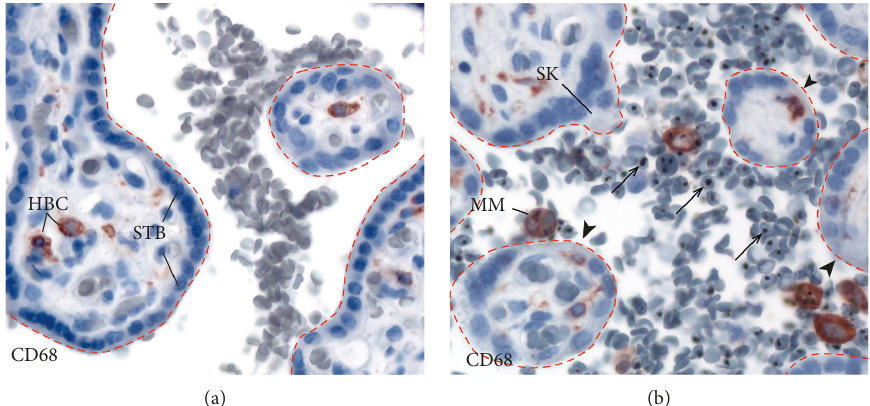
Figure 1: (a) Normal placenta. The dashed lines outline placental villi. Maternal RBCs are seen in the intervillous space. The placental villous (outlined with red dotted lines) is lined by the syncytiotrophoblast (STB). Fetal Hofbauer cells (HBCs) are located in the villous core. (b) Malaria-infected placenta. iRBCs (arrows) accumulate in the intervillous space, and the villous surface is denuded (arrowhead). Infected red blood cells (arrows) and maternal intervillous monocytes (MIM) are found within the intervillous space. A syncytial knot (SK) is a histologic sign of placental remodeling from pathologic processes. HBC: Hofbauer cell; STB: syncytiotrophoblast; MIM: maternal intervillous monocyte; SK: syncytial knot. Placental biopsies were stained with CD68, a monocyte/macrophage marker, and counterstained with